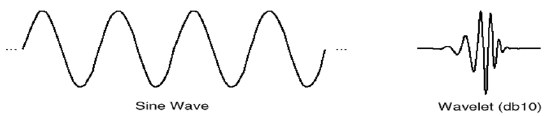
τ shift parameter and s →